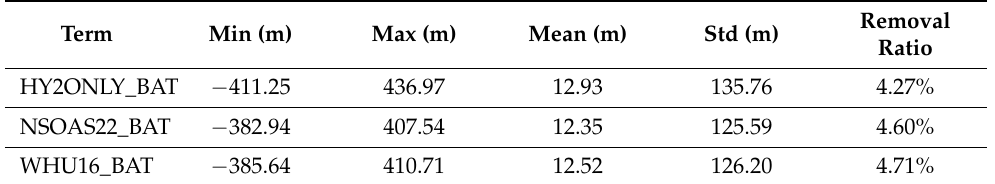
Table 4. Statistics on the differences between HY2ONLY_BAT, NSOAS22_BAT, WHU16_BAT inver- sion results and DTU21BAT.